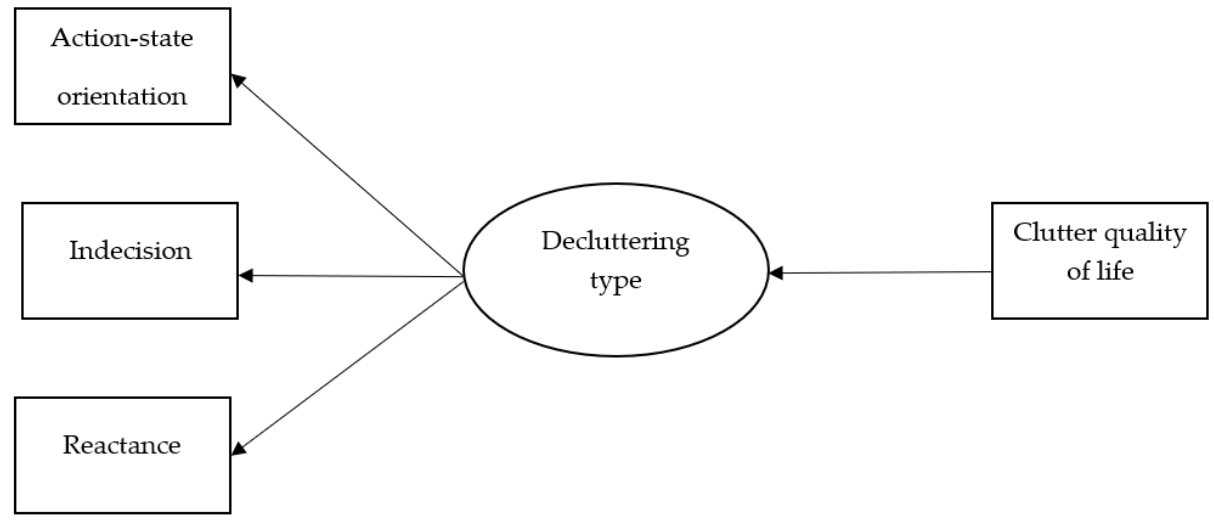
Figure 1. Latent Class Model.